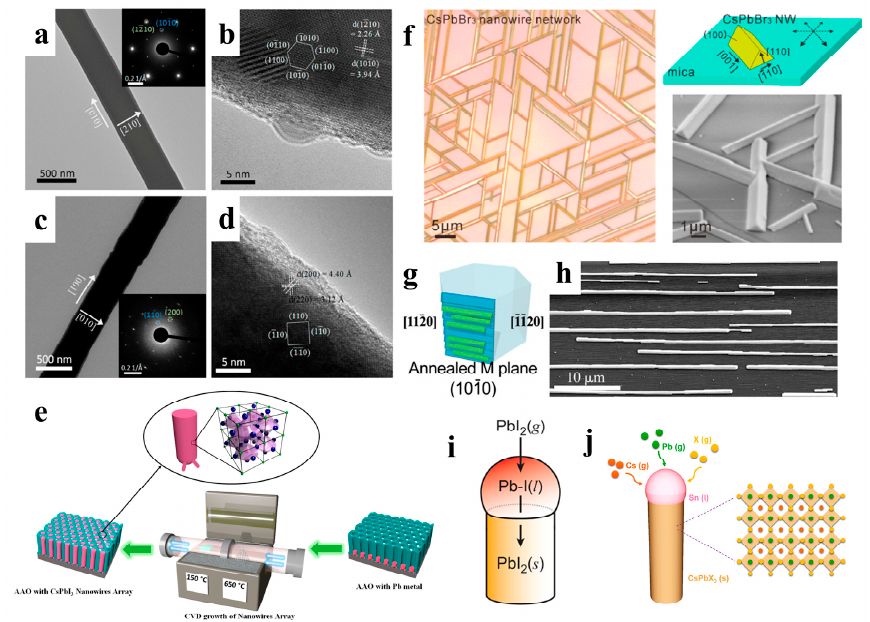
Figure 4. TEM and HRTEM images of ( a , b ) PbI 2 NW and ( c , d ) MAPbI 3 NW. Insets in ( a , c ) are their corresponding SAED patterns. Reproduced with permission from reference [48]. Copyright 2015, American Chemical Society. ( e ) Illustration of a vapor ‐ phase method for growing perovskite NWs in anodic aluminum membranes. Reproduced with permission from reference [49]. Copyright 2017, American Chemical Society. ( f ) Illustration of the vapor ‐ phase epitaxial growth of CsPbBr 3 NWs with a triangular cross ‐ section. Reproduced with permission from reference [52]. Copyright 2016, American Chemical Society. ( g ) Graphoepitaxial CsPbBr 3 NWs and SEM images of ( h ) an assembly of NWs. Reproduced with permission from references [48,53]. Copyright 2017, American Chemical Society. ( i ) Synthesis of PbI 2 NWs. Reproduced with permission from reference [61] Copyright 2017, American Chemical Society. ( j ) Schematic diagram illustrating the VLS growth process of CsPbX 3 NW using the Sn catalysts. Reproduced with permission from reference [63]. Copyright 2019, American Chemical Society.